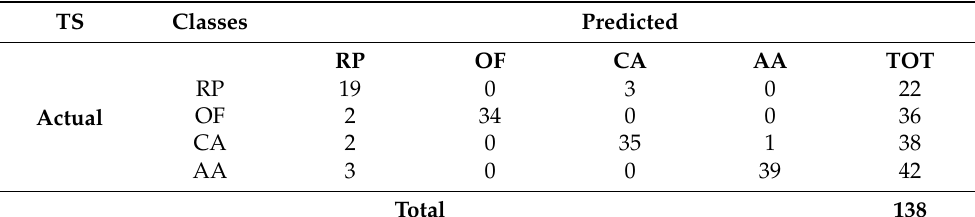
Table 3. Confusion matrix elaborated with the TS dataset.